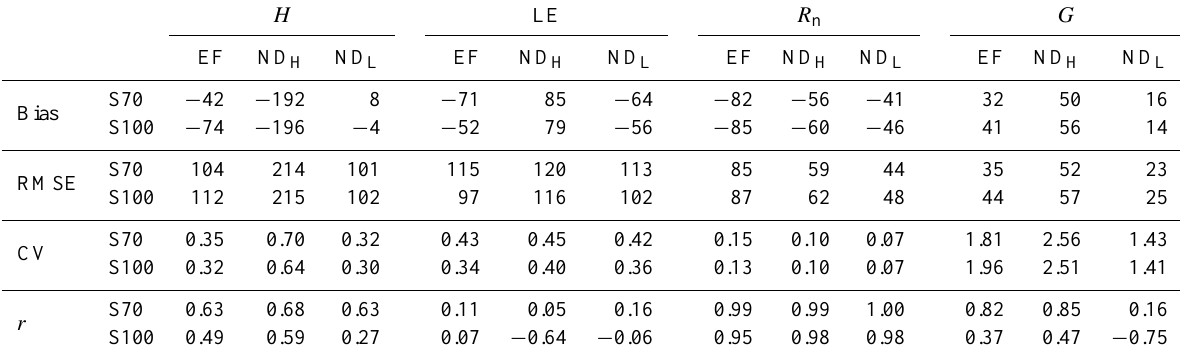
Table 7. Statistical comparison of modelled vs. observed fluxes at GLU with the meteorological inputs provided by the ERA-Interim data set, with the exception of incoming short-wave radiation which was taken from tower observations. Statistics are shown for the EF approach for estimating constant ratio used during the disaggregation procedure and for the non-disaggregated high, ND H , and low, ND L , resolution fluxes. Modelled fluxes are instantaneous at the time of satellite overpass and observed fluxes are 30min averaged EC measurements. The statistical parameters used are bias (modelled–measured), root mean square error (RMSE), coefficient of variation (CV – RMSE divided by mean of observed values), and correlation ( r ). Bias and RMSE are in Wm − 2 , the other parameters are unitless. H LE R